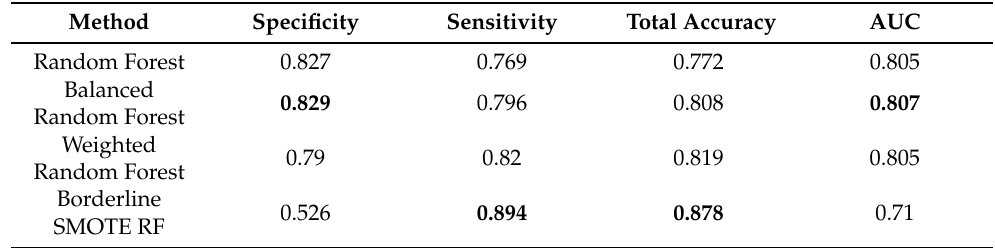
Table 3. Results for RF-based